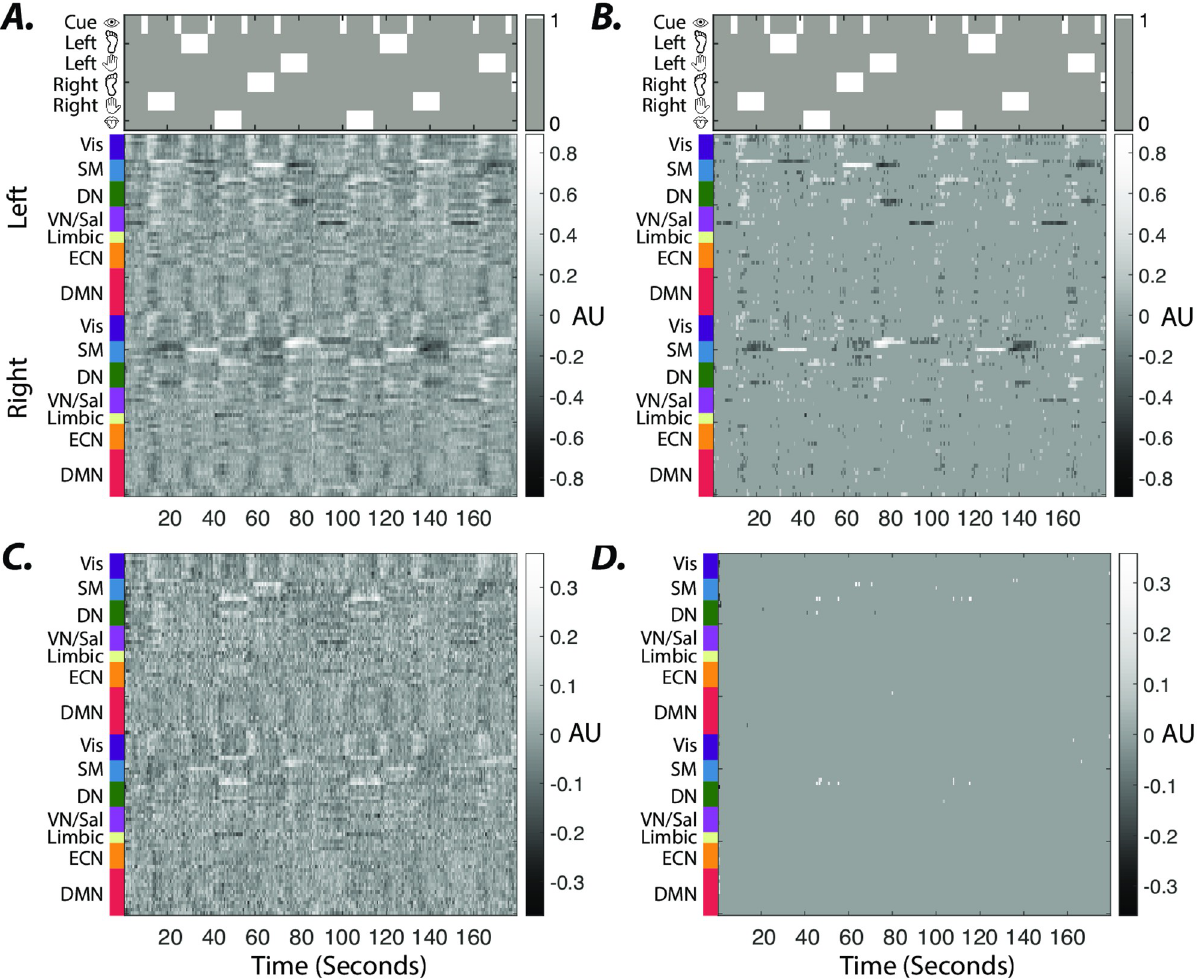
Fig 5. Average estimated external inputs in the motor task. Internal system parameters (i.e., A matrices) during full-length resting-state and motor scans were used to estimate the external inputs in panels A & C , respectively. Panels B & D show time points form panels A & C with significantly higher or lower average inputs estimated during motor task than resting-state scans (paired t − test, p < 0.05, false discovery rate (FDR) corrected for multiple comparisons). Top plots in panels A & B show onsets and durations of visual cues and motor task conditions—left foot, left hand, right foot, right hand, and tongue movement